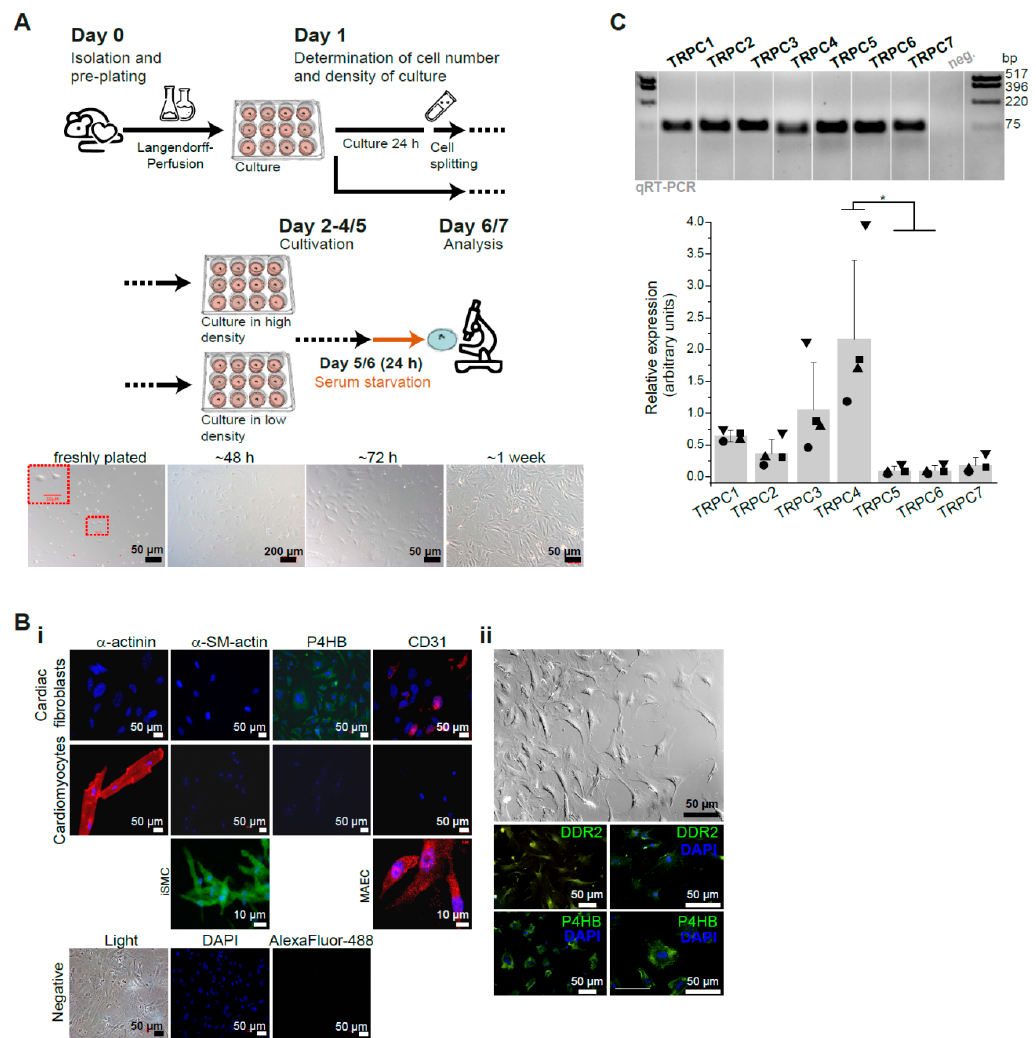
Figure 1. Characterization of primary isolated murine cardiac fibroblasts. ( A ) Isolated primary CFs from adult mice were cultured at high (>300 cells/mm 2 ) and low density as depicted. Phase contrast images showing the typical morphology and confluence of cultured fibroblasts at several time points of the culture are included. ( B ) Immunocytochemical characterization of primary cultures of CFs using antibodies against α -actinin, α -smooth muscle (SM) actin, P4HB and CD31 ( Bi ) or additionally DDR2 ( Bii ) is shown. ( C ) Expression analysis by qPCR from Trpc channels in four independent (n = 4 hearts) primary cultures of CFs. bp: base pair. * p < 0.05 depicted are according to Dunn’s post-hoc comparisons after Kruskal-Wallis.